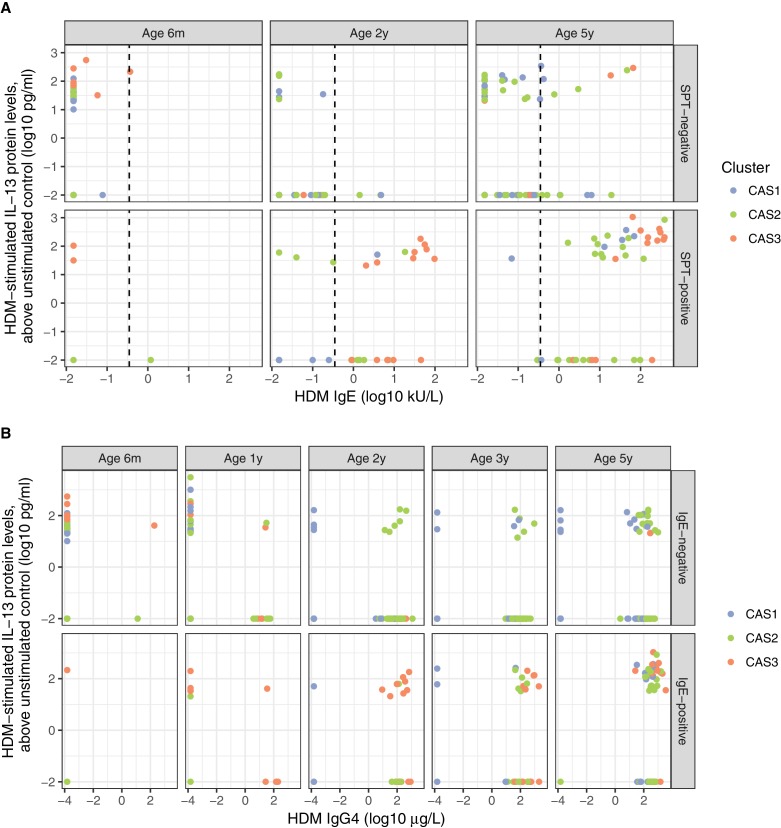
Distinct biological signals of HDM IgE, IgG4, SPT, and Th2 cytokine (IL-13).(A) Th2 cytokine (IL-13) to HDM stimulation of PBMCs in vitro, vs.HDM IgE responses in vivo, stratified by age of testing, and SPT result (positive denoted by ≥2 mm at age <2 or 3 mm at age 5). Dotted line represents traditional threshold for HDM IgE-positive result (0.35 kU/L). Note the significant number of individuals on either side of the dotted line for both HDM SPT-positive and negative subgroups. (B) Th2 cytokine (IL-13) to HDM stimulation of PBMCs in vitro, vs. HDM IgG4 responses in vivo, stratified by age of testing and HDM IgE result (positive denoted by ≥0.35 kU/L).